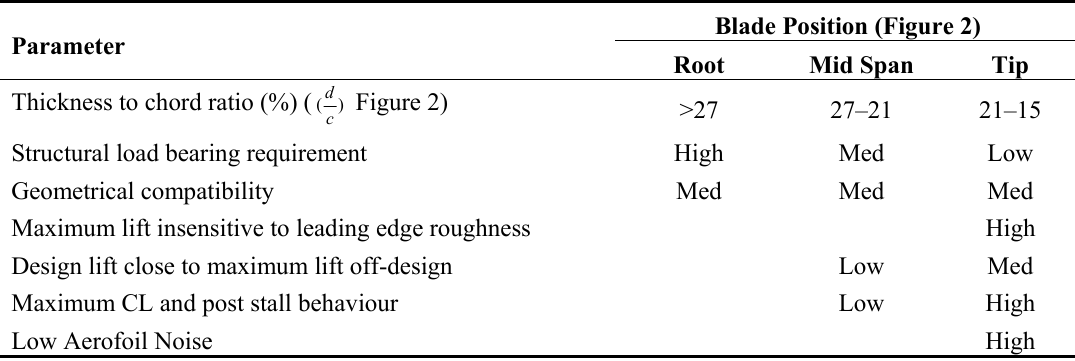
Table 6. The aerofoil requirements for blade regions